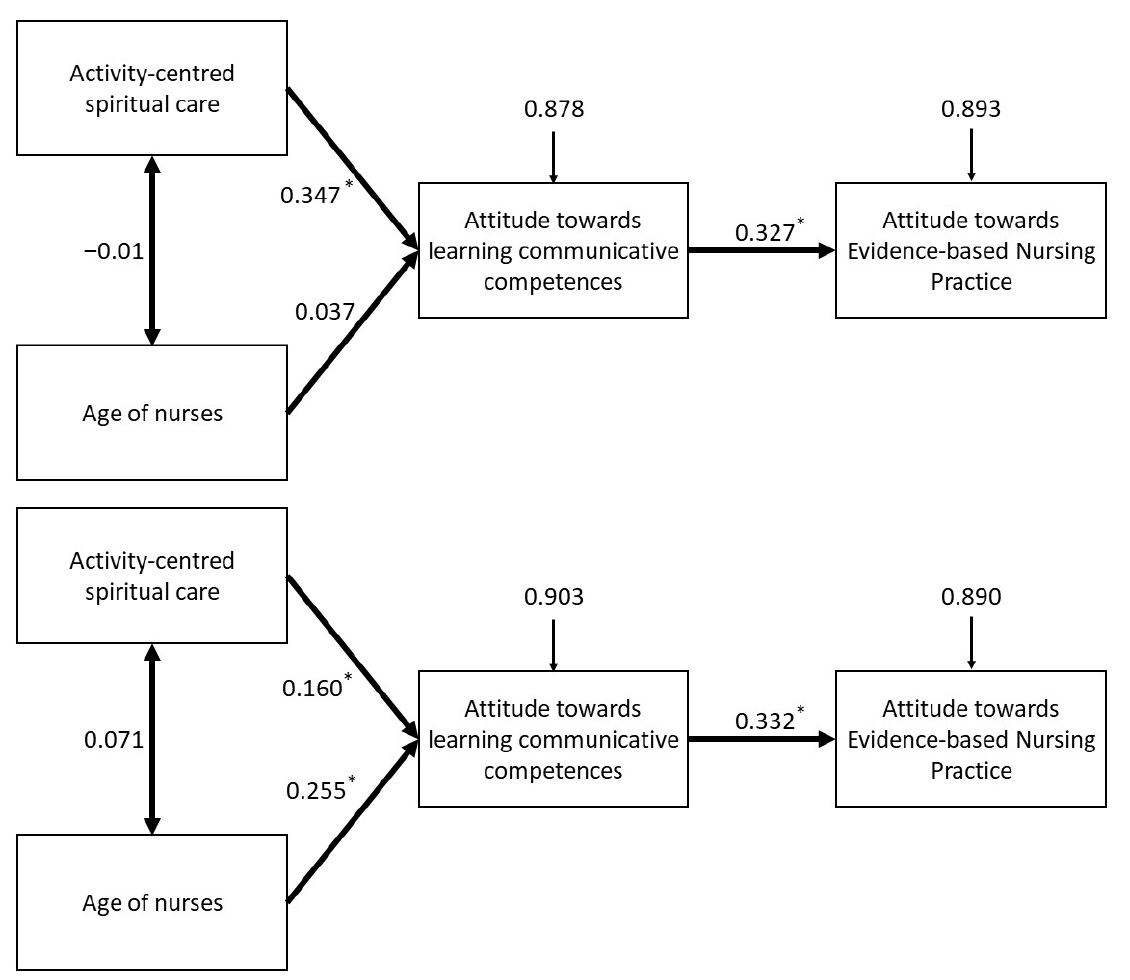
Figure 3. Pathway diagram for BP group (above) and MP group (below). Correlations between independent variables are represented with a double ‐ sided arrow. Direct effects are represented with a one ‐ sided arrow. The numbers above the arrow indicate the value of standardised regression weights. The numbers before the arrow show residual variances. The asterisk (*) mark stands for standard regression weights, meaning the p value is under 0.05.